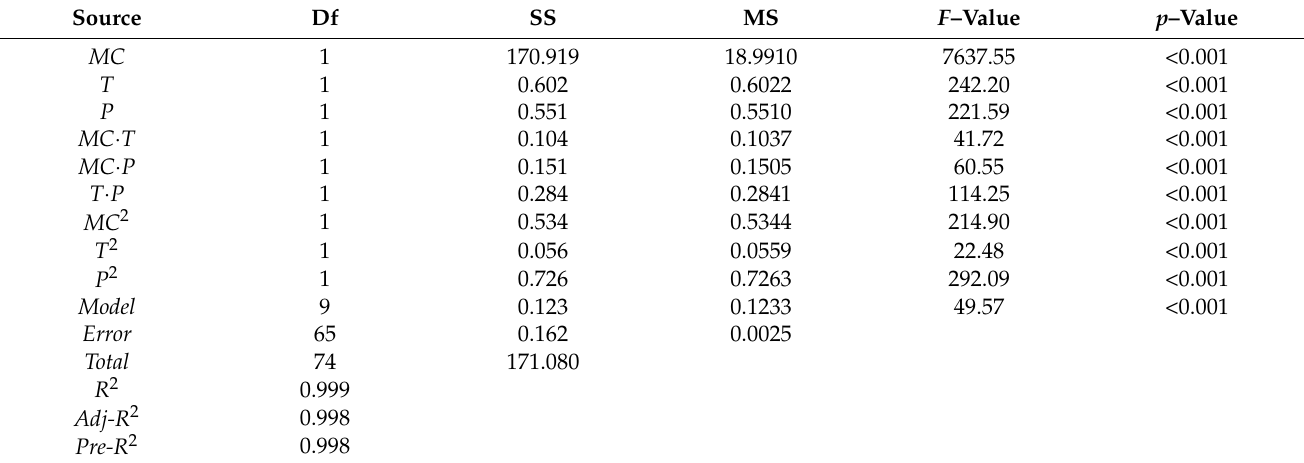
the drying process. Table 4. Variance evaluation of linear, quadratic, and interaction terms for the response and coefficient of the prediction models. Source